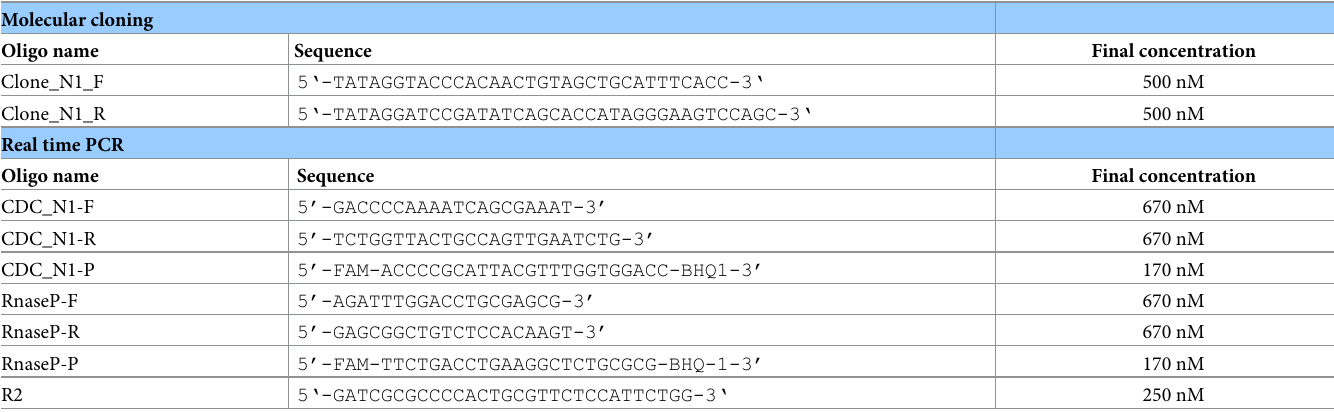
Table 1. Primer and probe sequences used in this